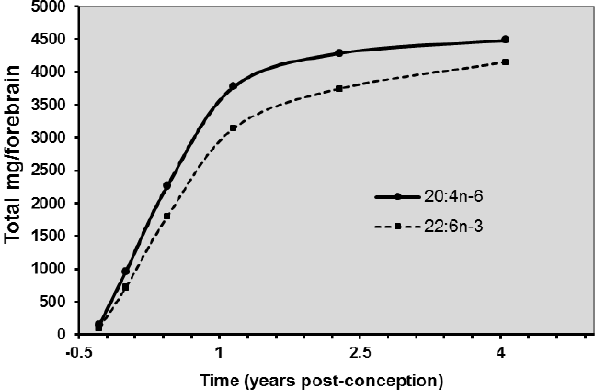
Figure 1. Long ‐ chain polyunsaturated fatty acids (LCPUFA) accretion in the human brain during Figure 1. Long-chain polyunsaturated fatty acids (LCPUFA) accretion in the human brain during perinatal development (Data from Martinez [15]). perinatal development (Data from Martinez